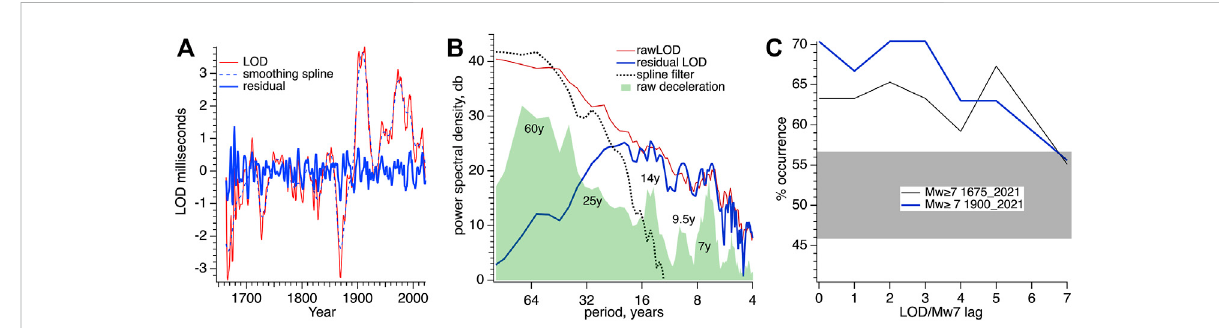
FIGURE 6 (A) . LOD time series (red) and its residual (blue) after removing a smoothing spline fi t to the LOD data. (B) . Multi-taper spectral analyses (expressed as db with arbitrary zero) of the deceleration time series (green shading), smoothing spline (dotted black line), the raw (red) and residual (blue) length-of-day data (red). (C) . percentage of earthquakes occurring during periods of positive excursions in residual shown in (A) . Grey area indicates region anticipated from random